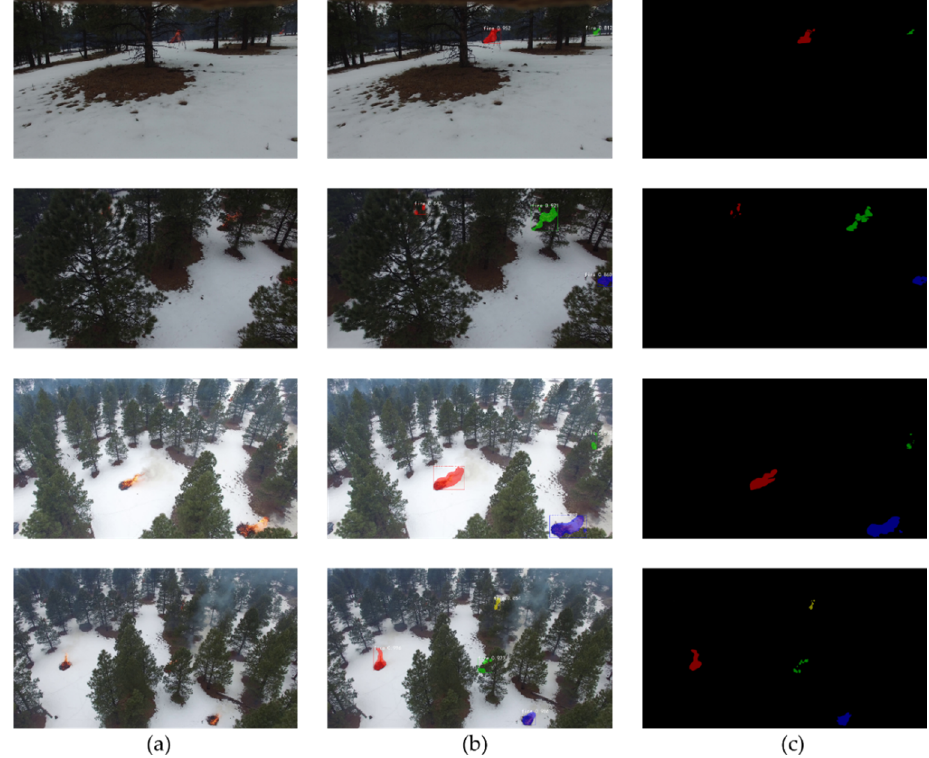
Figure 8. Results of MaskSU R-CNN for forest-fire instance segmentation: ( a ) raw images; ( b ) predicted results; and ( c ) ground truth labels.